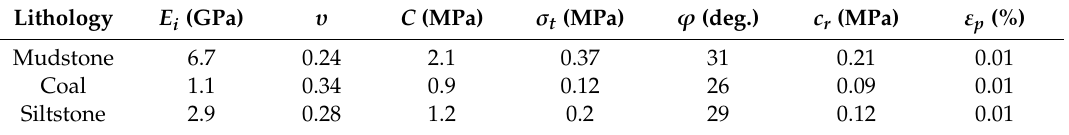
Figure 4. Numerical model. ( a ) Model size, ( b ) Roadway support. Table 1. Mechanical parameters of the rock mass [24–26].